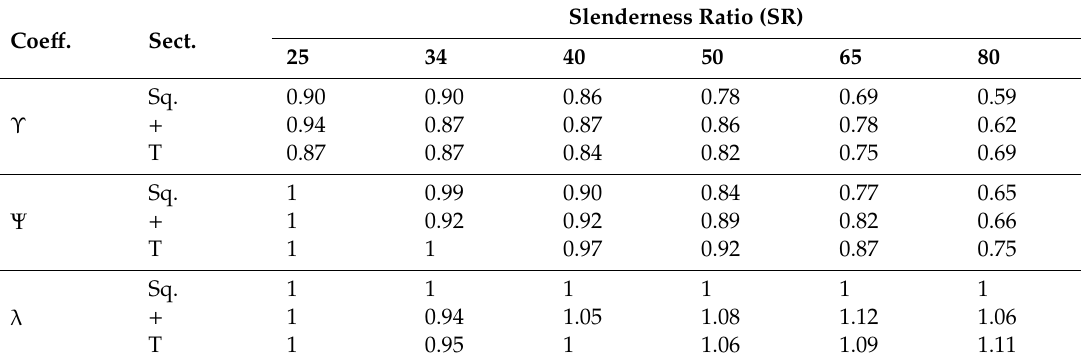
Table 4. Coe ffi cients of two proposed